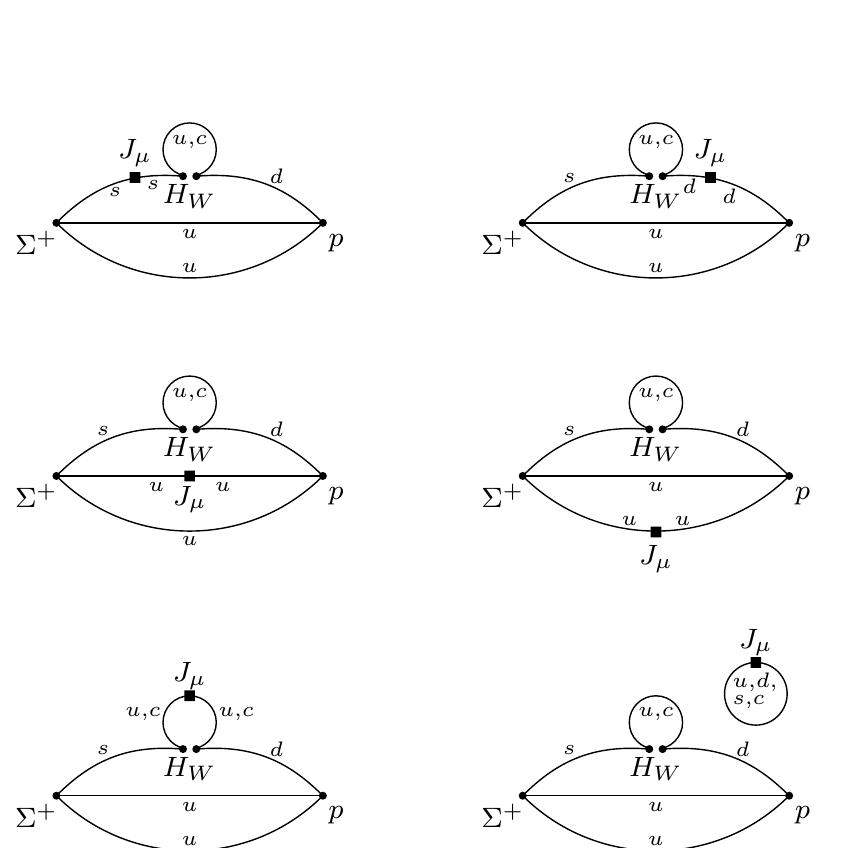
Figure 5 . Four-point diagrams for the S class. The squared vertex shows the insertion of the electromagnetic current J µ